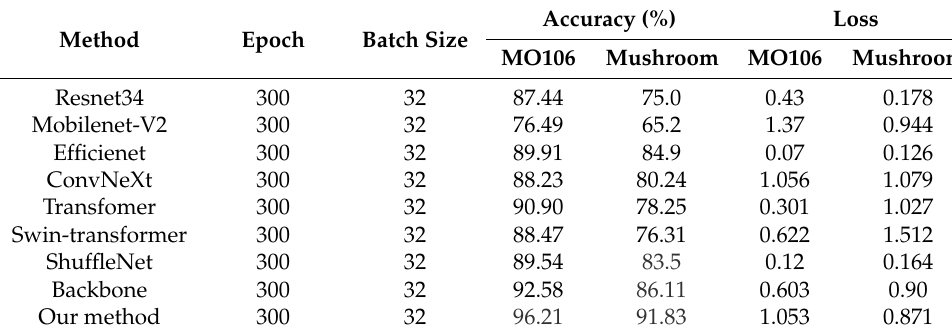
Table 1. Comparison with other methods on two datasets.